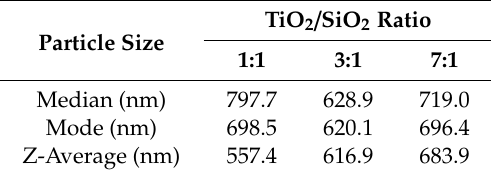
Table 4. TiO 2 /SiO 2 composite particle size analysis (PSA) characterization.